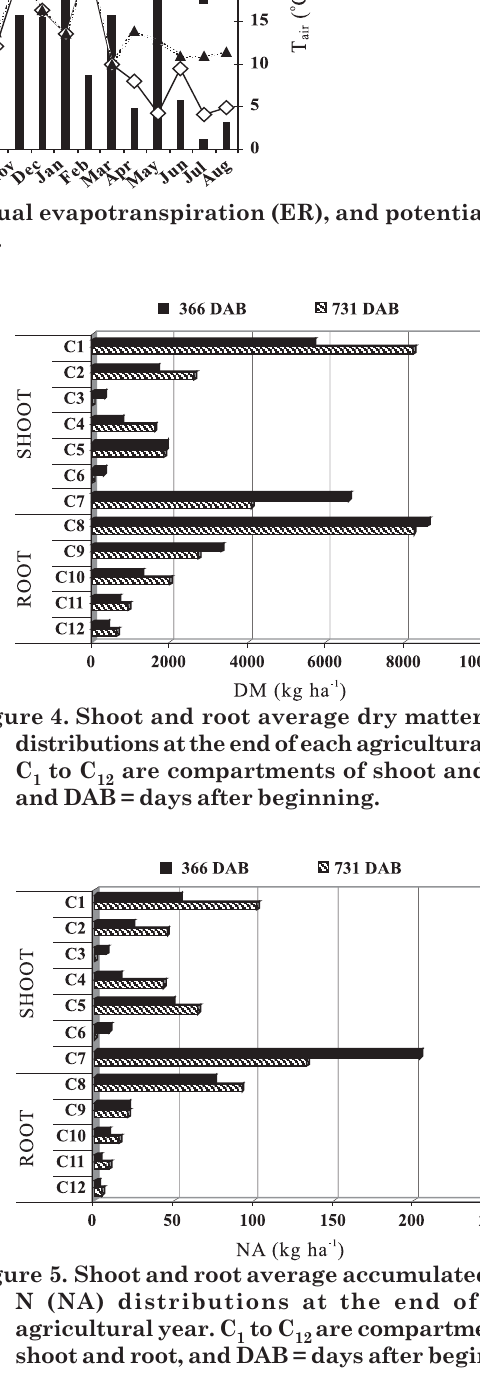
Total soil-N (NA) decreased with soil depth (Figure 6). The surface layers C as much soil-N as the deeper layers C